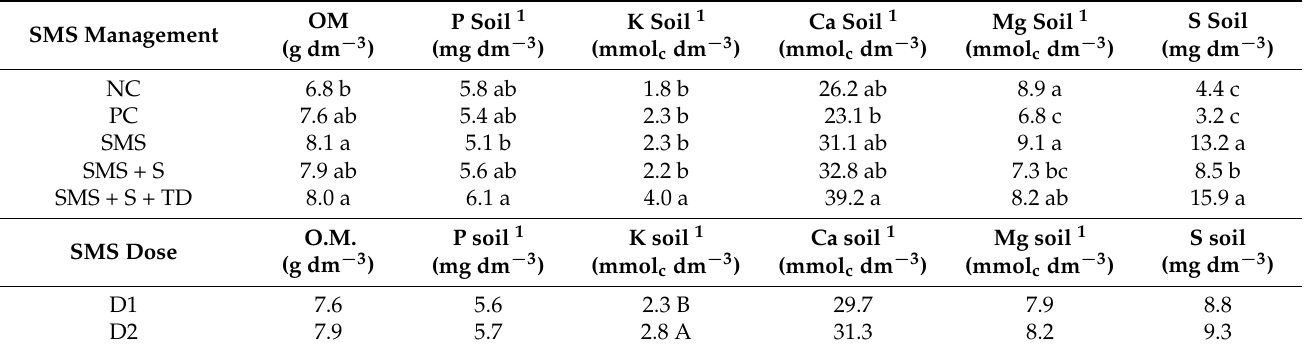
Table 4. Mineral composition and organic matter of soil in maize cultivation at 70